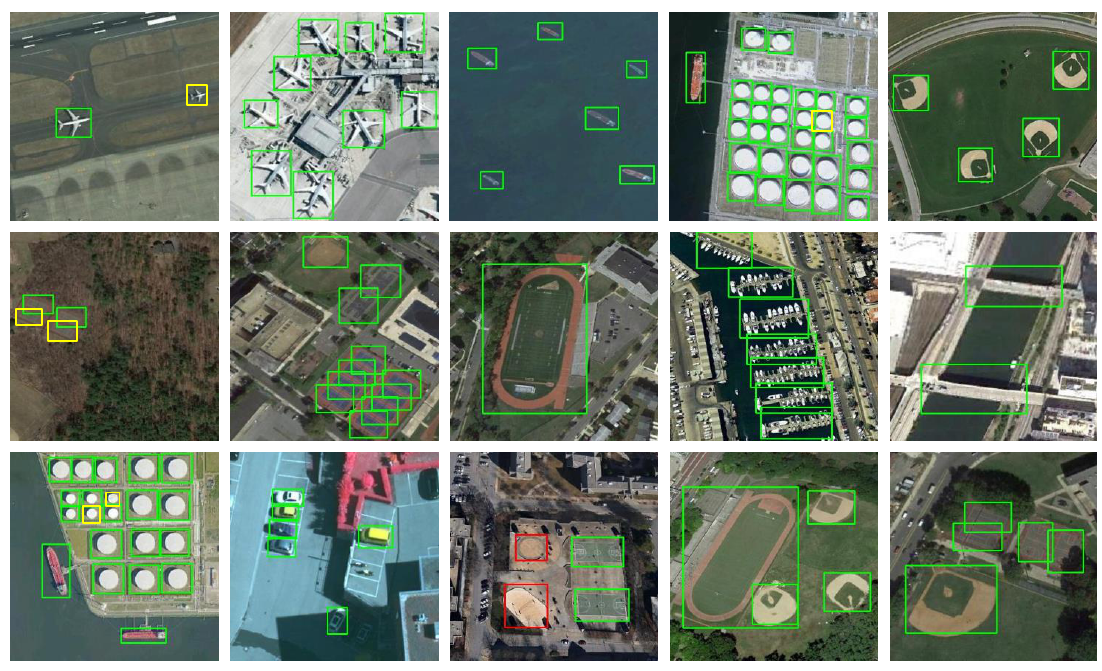
Figure 7. Some object detection results obtained by using the proposed method. The true positives, false positives, and false negatives are denoted by green, red, and yellow rectangles,